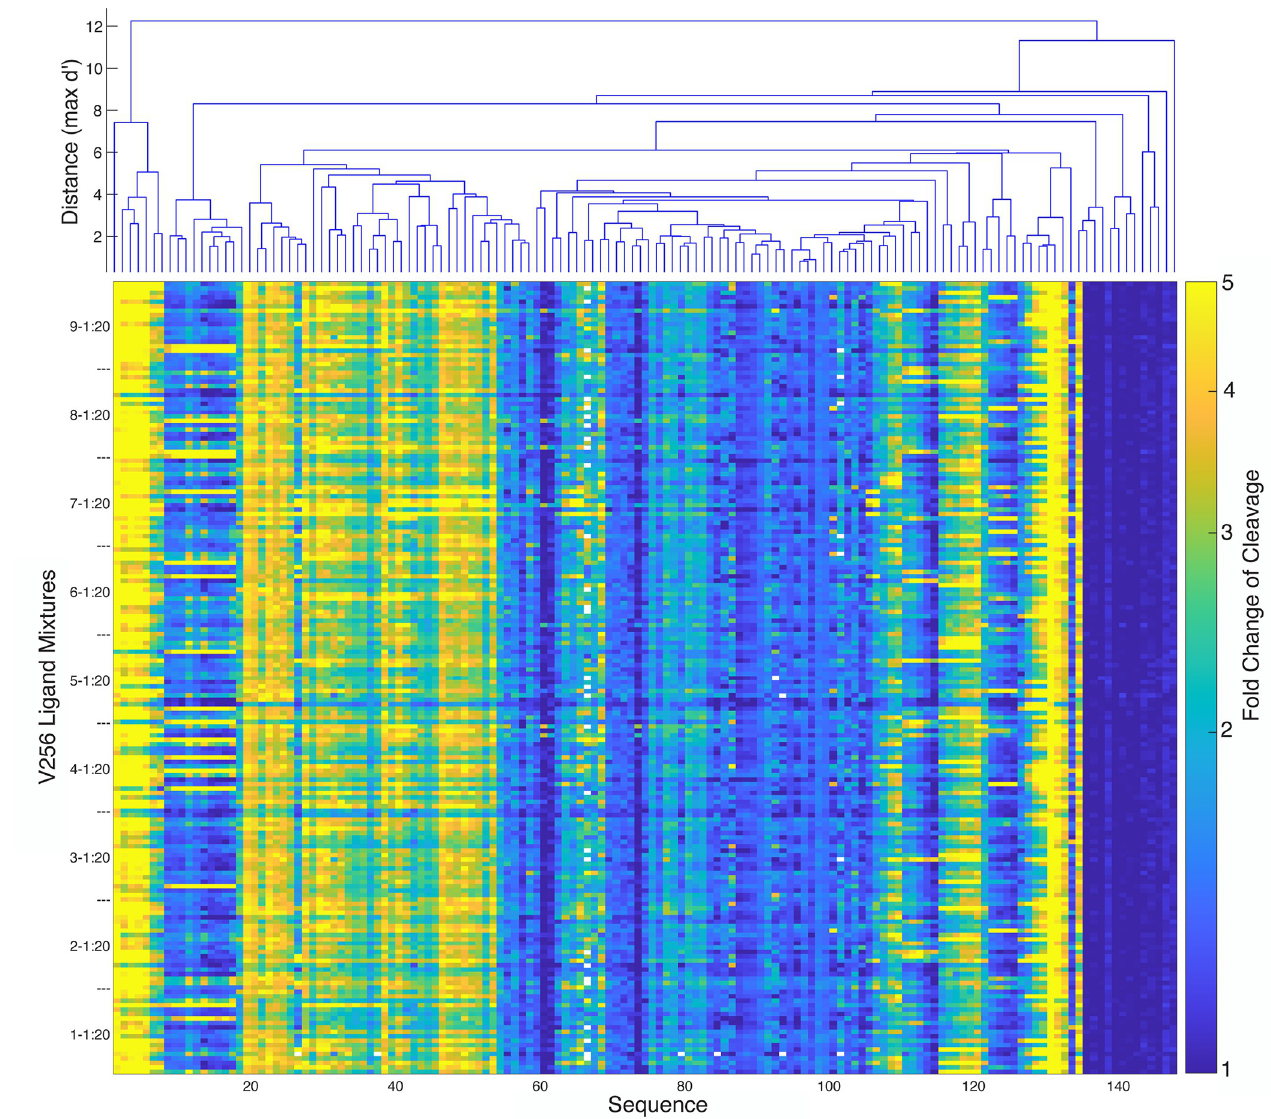
Fig 3. CleaveSeq results of select biosensors against deconvolution vectors shows clusters of similar biosensors. The pseudocolor plot shows the fold change of cleavage for each of 147 sequences (the most-frequent representative of clusters of sequences that showed similar response patterns) in the presence of each of the 180 mixtures of 256 compounds, each at 2 μ M concentration. Sequences are ordered based on hierarchical clustering of the patterns of response with the dendrogram above showing the response similarities. Dendrogram distances (d’) are the maximum (over all 180 vectors) of the log of the ratio of fold changes divided by the standard deviation of the